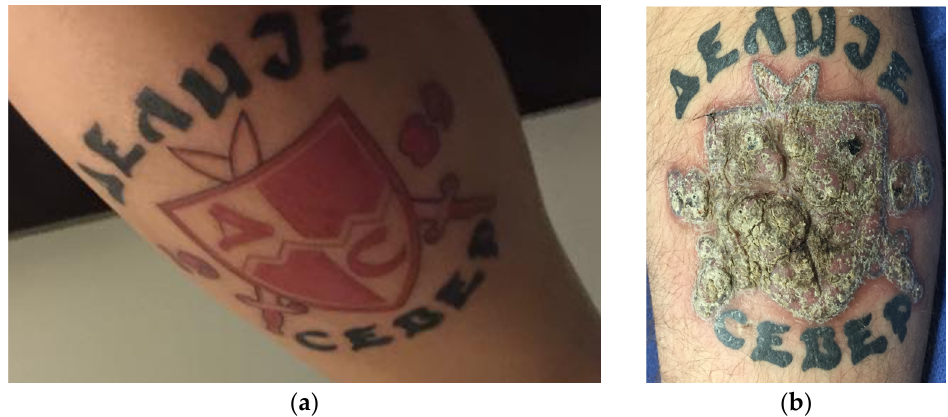
Figure 1. Photograph taken immediately after tattoo was imprinted ( a ). Photograph taken six months after receiving the tattoo. Note the scaly, raised exophytic lesion in areas tattooed with red ink only while the black ink areas remain spared ( b ).